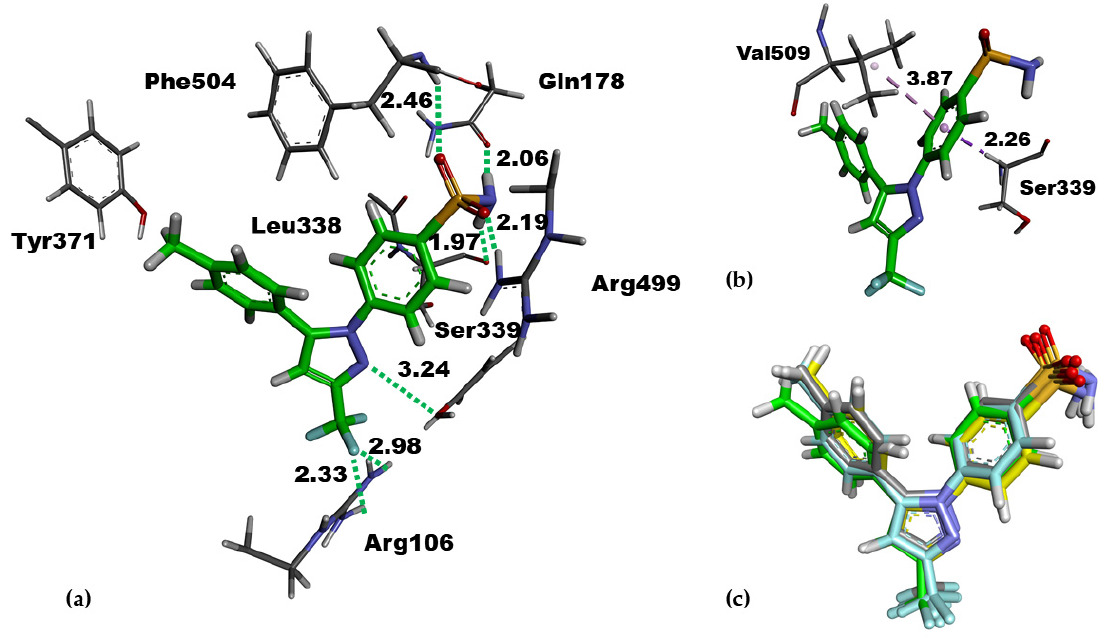
Figure 2. Relaxed pose obtained from a 1 ns molecular dynamics (MD) simulation of celecoxib (stick representation in green). ( a , b ) Binding interactions of celecoxib with key amino acids in the catalytic pocket of COX-2. The unit of distance in proximity is angstrom. ( c ) The superposition of the MD structure of celecoxib (green) and the best-docked pose of celecoxib from AutoDock (grey) with the RMSD value of 0.68 Å, ChemPLP (yellow) with the RMSD value of 0.55 Å and GoldScore (Cyan) with the RMSD value of 0.56 Å.